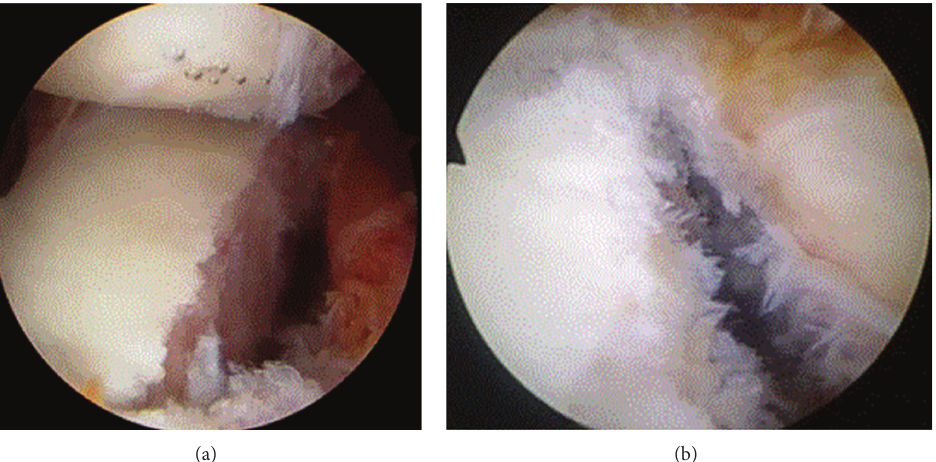
Figure 3: Arthroscopic views of the glenoid demonstrating (a) acute and (b) chronic glenoid bone defects in patients with chronic shoulder